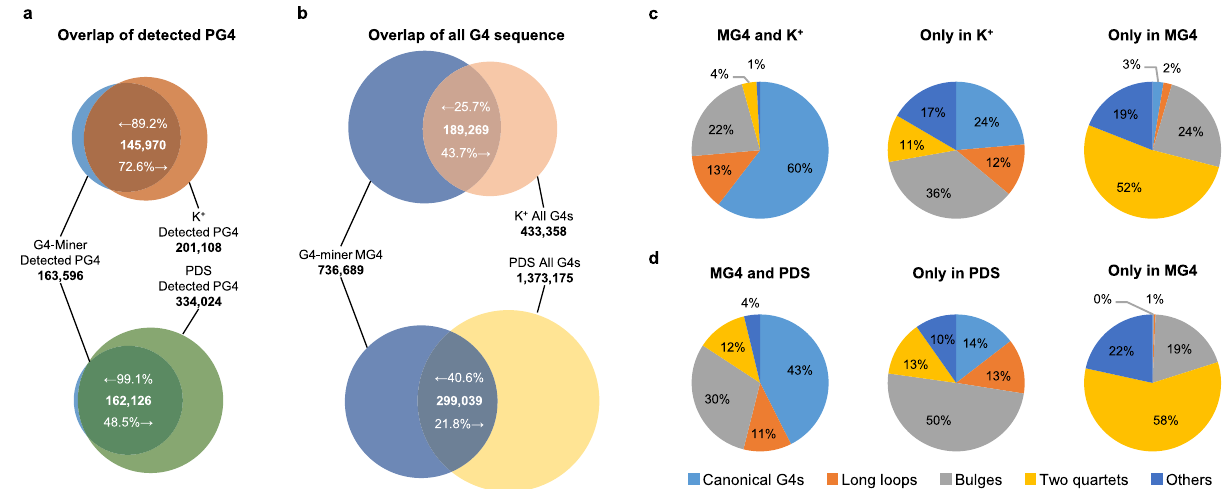
Fig. 4 Comparison with the result of the optimized G4-seq. a Overlap between PG4s that were detected in MG4s in standard sequencing buffers and K + or PDS conditions 26 . b Overlap between MG4s in standard sequencing buffers and K + or PDS conditions 26 . c Prevalence of G4 sequences detected both under K + conditions and by G4-miner, only detected under K + conditions and only detected by G4-miner. d Prevalence of G4 sequences detected both under PDS conditions and by G4-miner, only detected under PDS conditions and only detected by G4-miner.